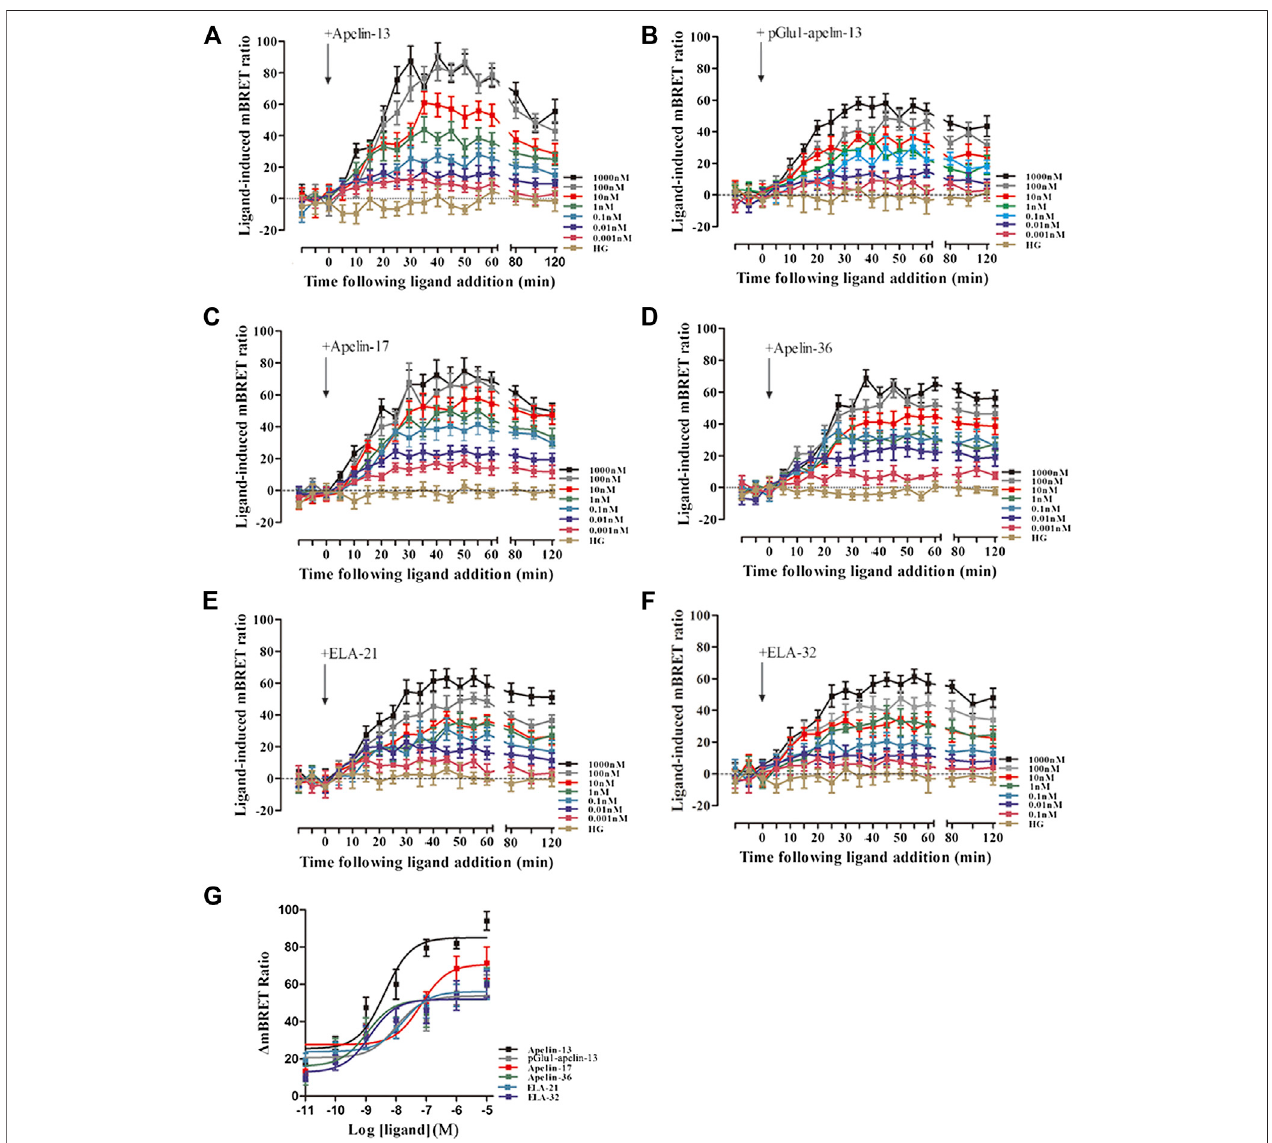
FIGURE 9 | The time-response curve (A – F) and dose-response curve (G) of interactions between β -arrestin 2 and AP2 induced by APJ upon activation by the six agonists in different concentrations, obtained from real-time dynamic BRET determination. Control group (HG, Cells were stimulated with high glucose). p < 0.05 was considered as statistically signi fi cant. The BRET assay to measure the six peptide (0.001 – 1,000 nM) induced concentration-response curves of β -arrestin 2 and β 2- adaptinrecruitmenttoAPJat30 minpost-stimulation (G) .Thedatarepresentmeans ± SEMoffourindependentexperiments.Statisticalanalysis( Supplementary Table S8